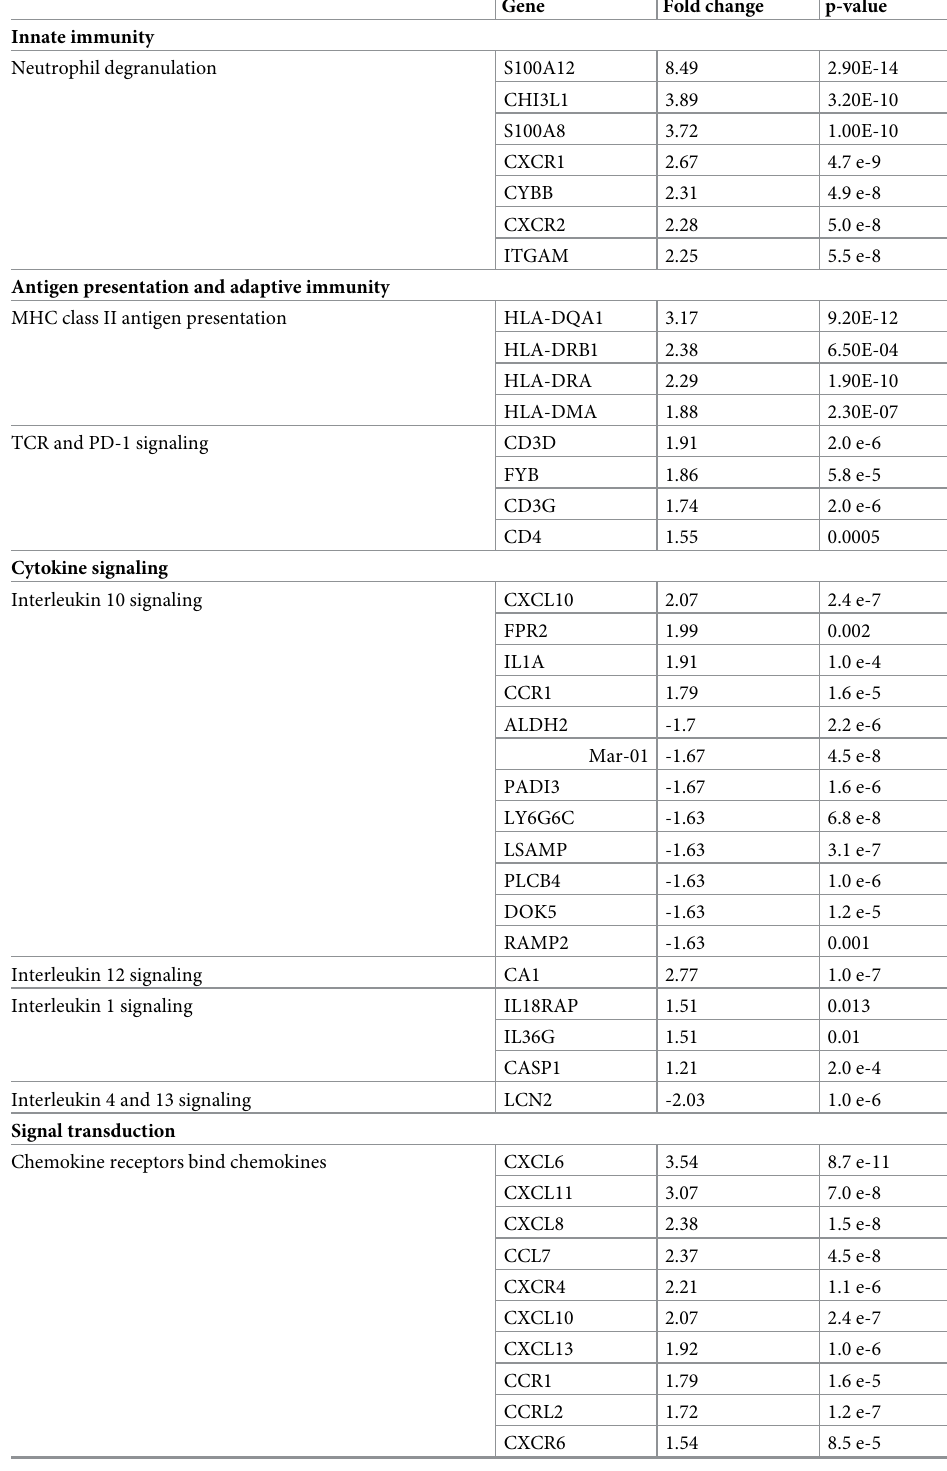
Table 2. Selected differentially expressed genes based on fold